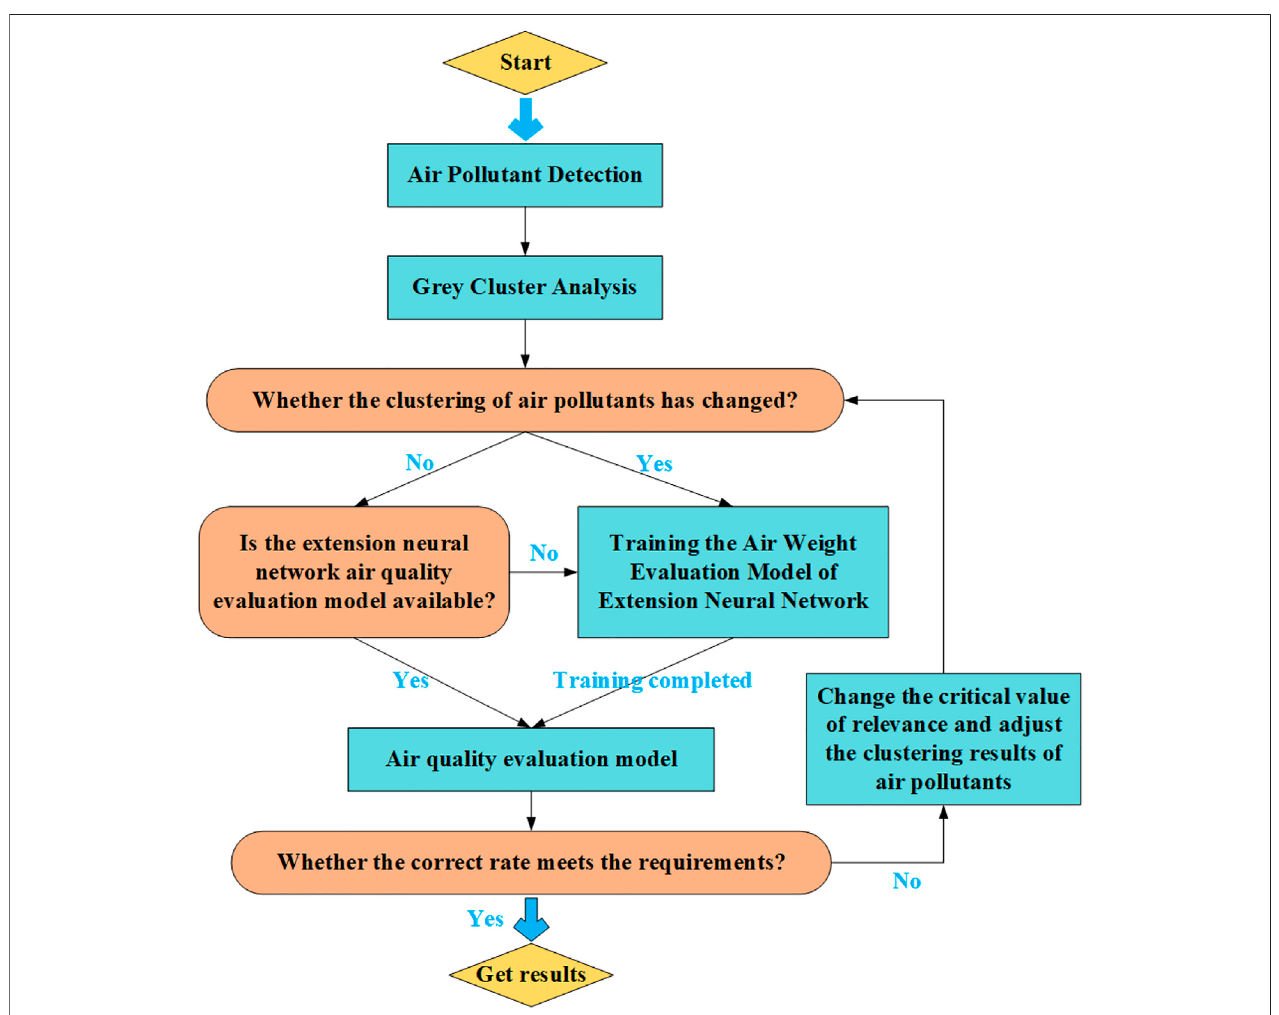
FIGURE 3 | Overall process of cable trench air